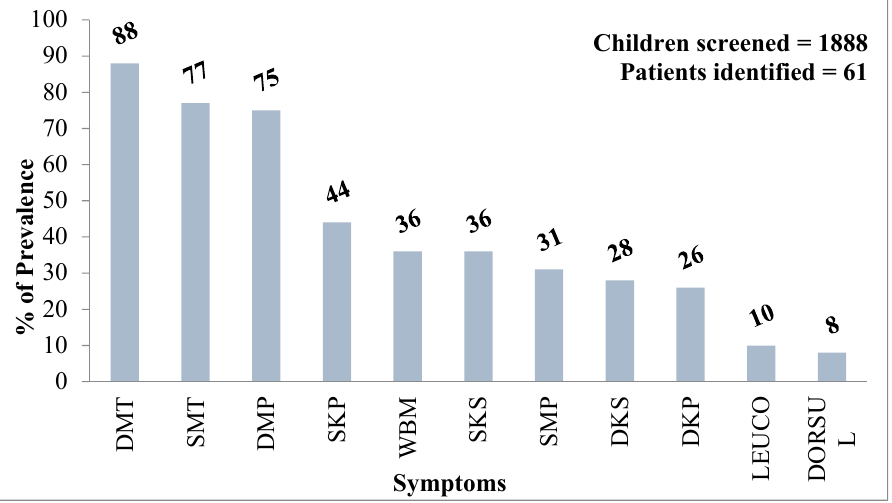
Figure 4. Common dermatological features due to arsenicosis among surveyed children of Bihar, India.